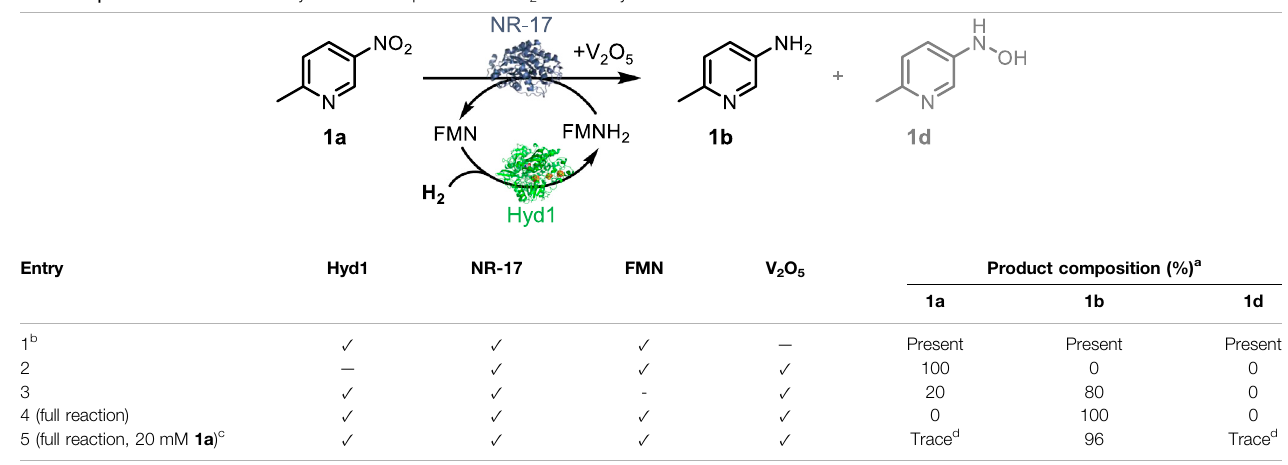
TABLE 2 | Evaluation of the necessity for each component in the H 2 -driven enzymatic nitroreduction.